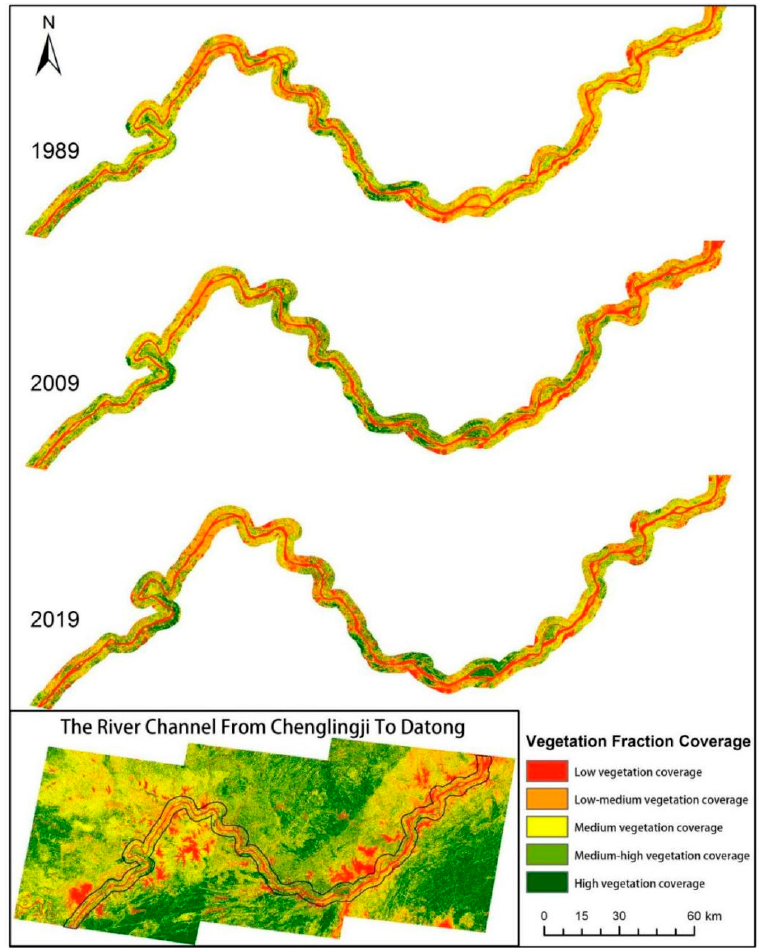
Figure 9. Map of vegetation coverage within 5 km from the Chenglingji to Datong River channel.